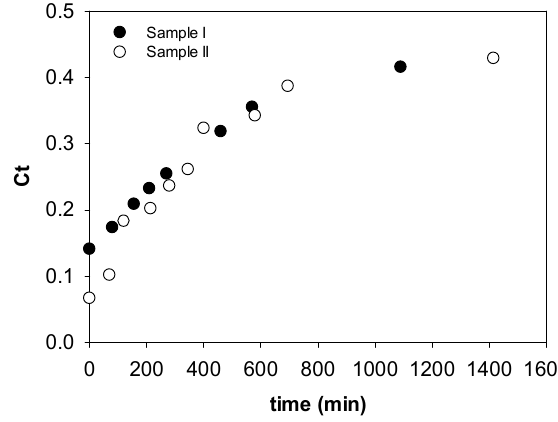
Figure 5. Impact of stick water mass fraction solids on the rate of concentration. 177